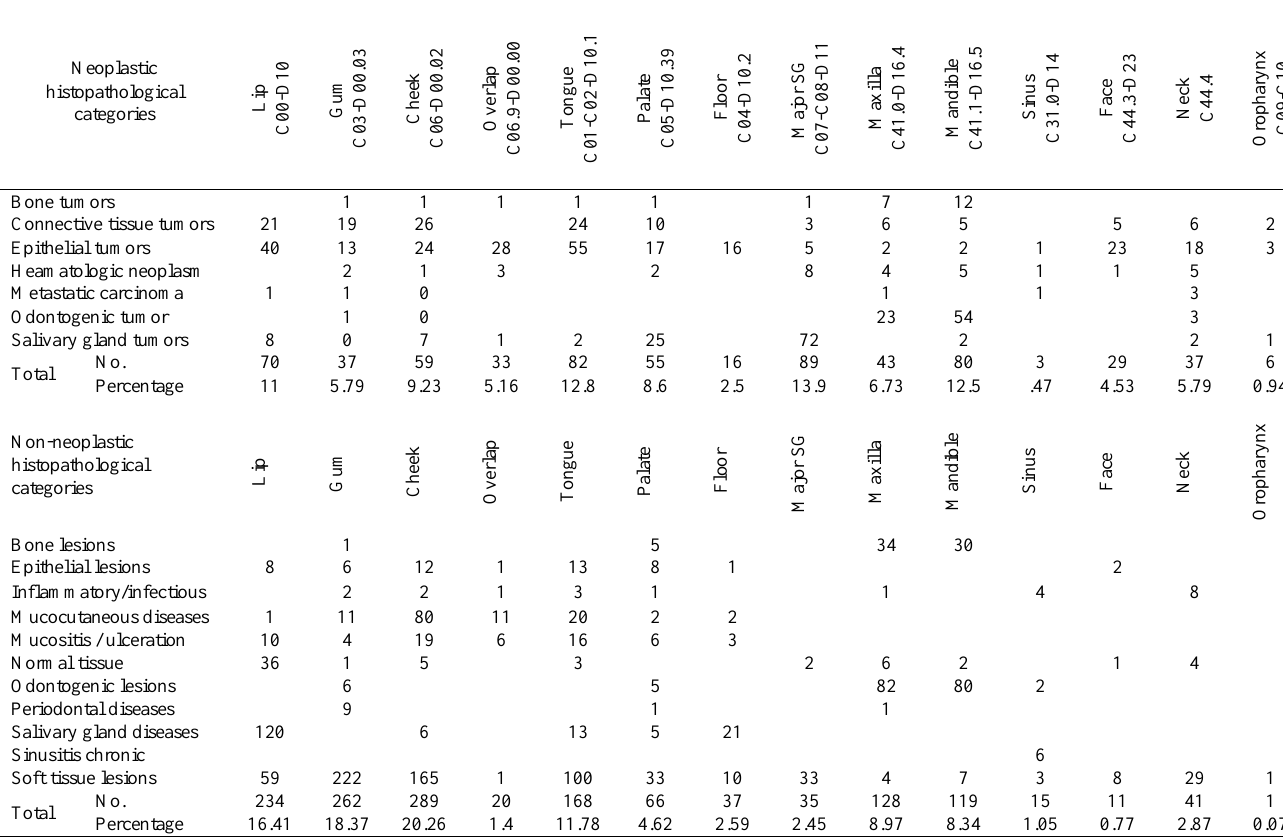
Table 2 The histopathological categories of oral and maxillofacial surgical lesions distributed according to the site # # sites of 35 lesions (1.66%) were not recorded in